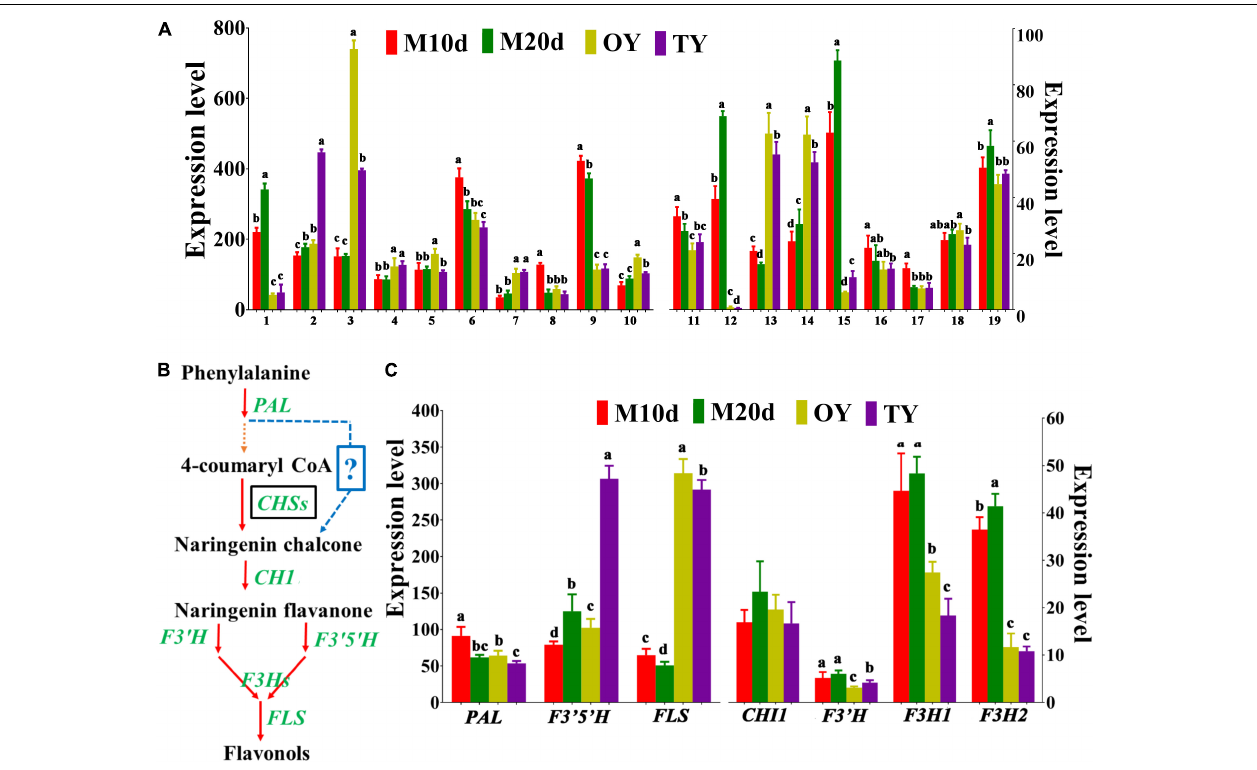
FIGURE 6 | Differential expression of the enzymes involved in polysaccharide and flavonoid biosynthesis identified in S. sanghuang Kangneng . (A) The expression levels of genes involved in polysaccharide biosynthesis in different developmental stages. (B) Putative pathway of flavonoid biosynthesis in S. sanghuang Kangneng . Black box, no homologous gene was found in the fungal genome; ?, unknown reactions in the fungus. (C) The expression levels of genes involved in flavonoid biosynthesis in different developmental stages. Different lowercase letters marked on the bars in each graph denote significant differences ( P < 0.05).